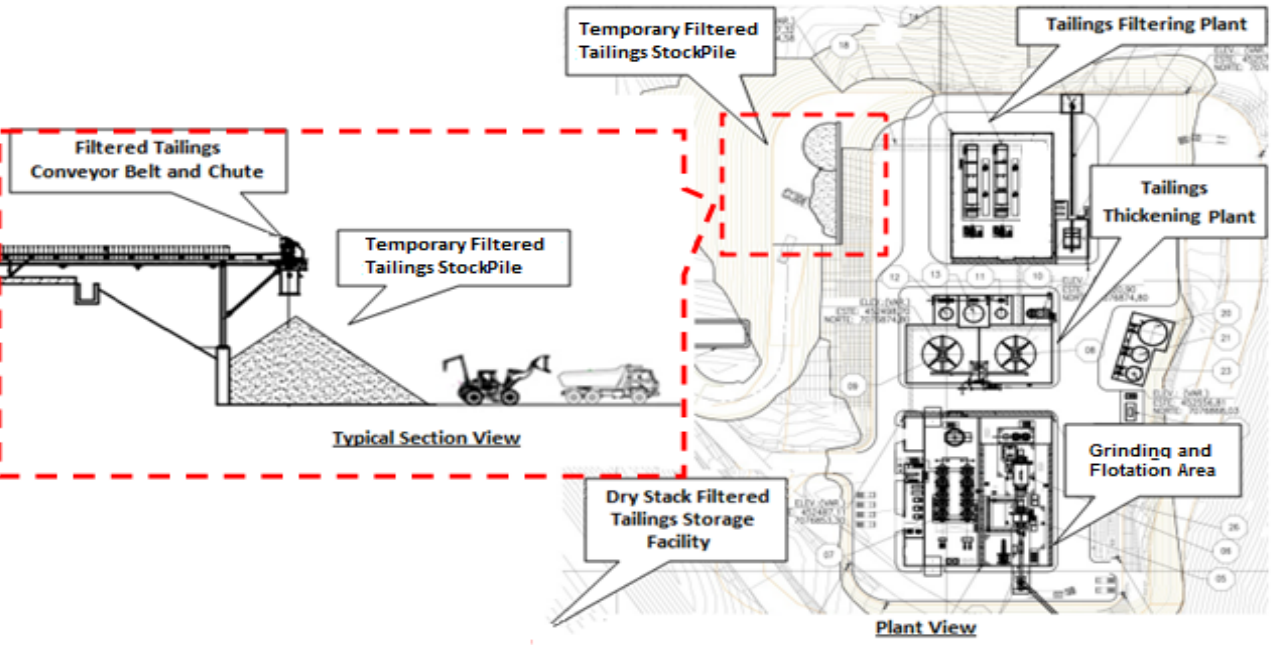
Figure 5. Typical Layout and Profile of Filtered Tailings Temporary Stockpile [18].